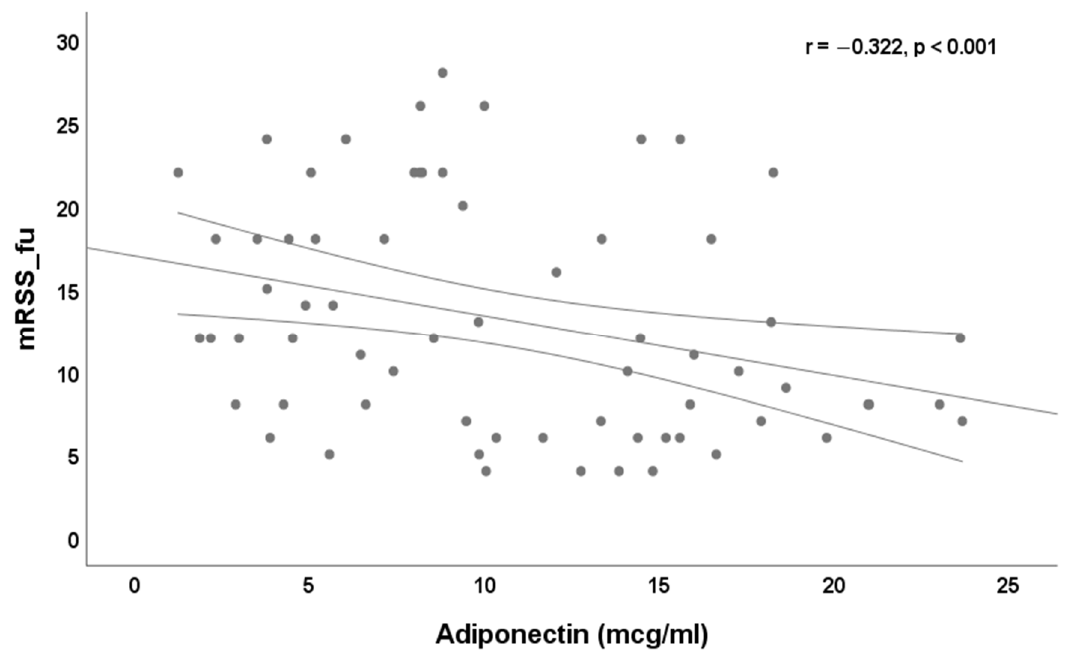
Figure 1. Correlation between baseline serum level of adiponectin (mcg/mL) and baseline mRSS (r = − 0.303, p < 0.05).